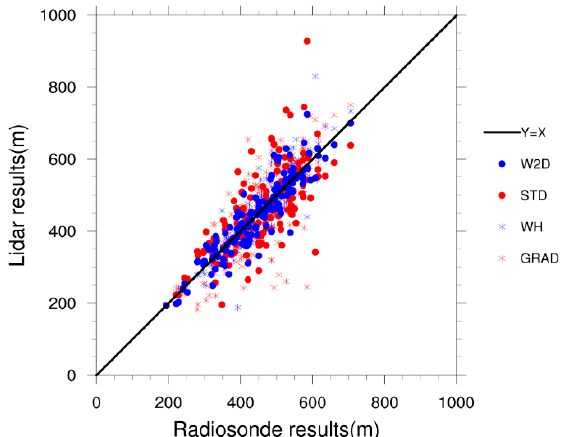
Figure 7. Comparisons of different lidar methods with the radiosonde observations, the black line is the reference line of Y = X.